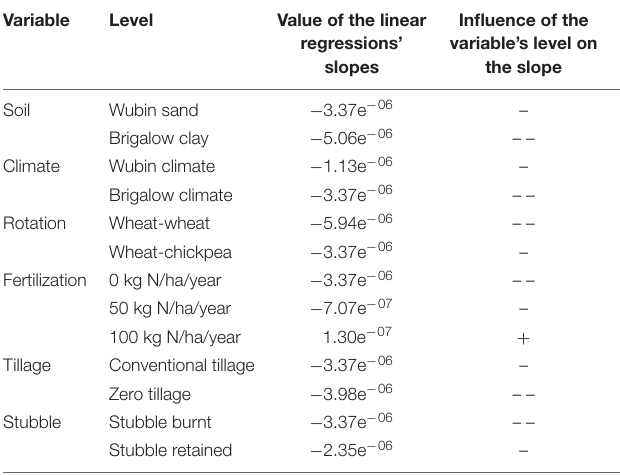
TABLE 6 | Influence of the types of soils, climates and management practices on the rate of SOC loss over the 90 years simulated